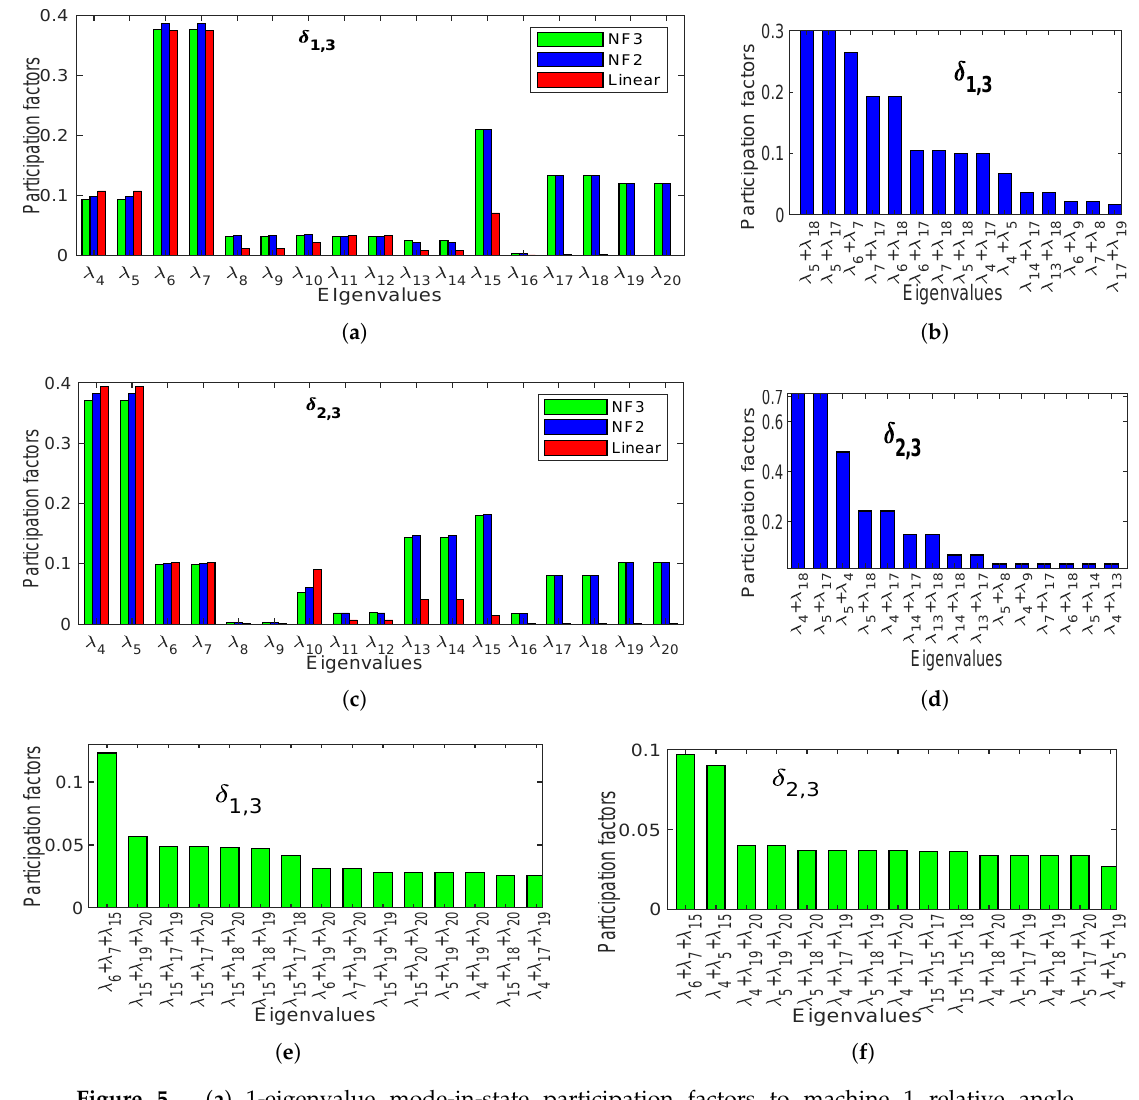
Figure 5. ( a ) 1-eigenvalue mode-in-state participation factors to machine 1 relative angle. ( b ) 2-eigenvalue participation factors to machine 1 relative angle. ( c ) 1-eigenvalue participation factors to machine 2 relative angle. ( d ) 2-eigenvalue participation factors to machine 2 relative angle. ( e ) 3-eigenvalue participation factors to machine 2 relative angle. ( f ) 3-eigenvalue participation factors to machine 2 relative